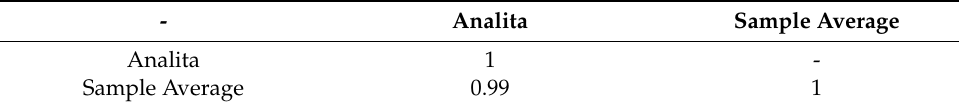
Table 1. Correlation between % passing weight and % passing amount.